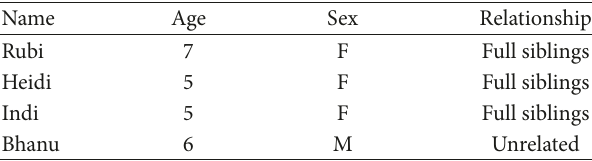
Table 1: Members of the Asiatic lion pride at London